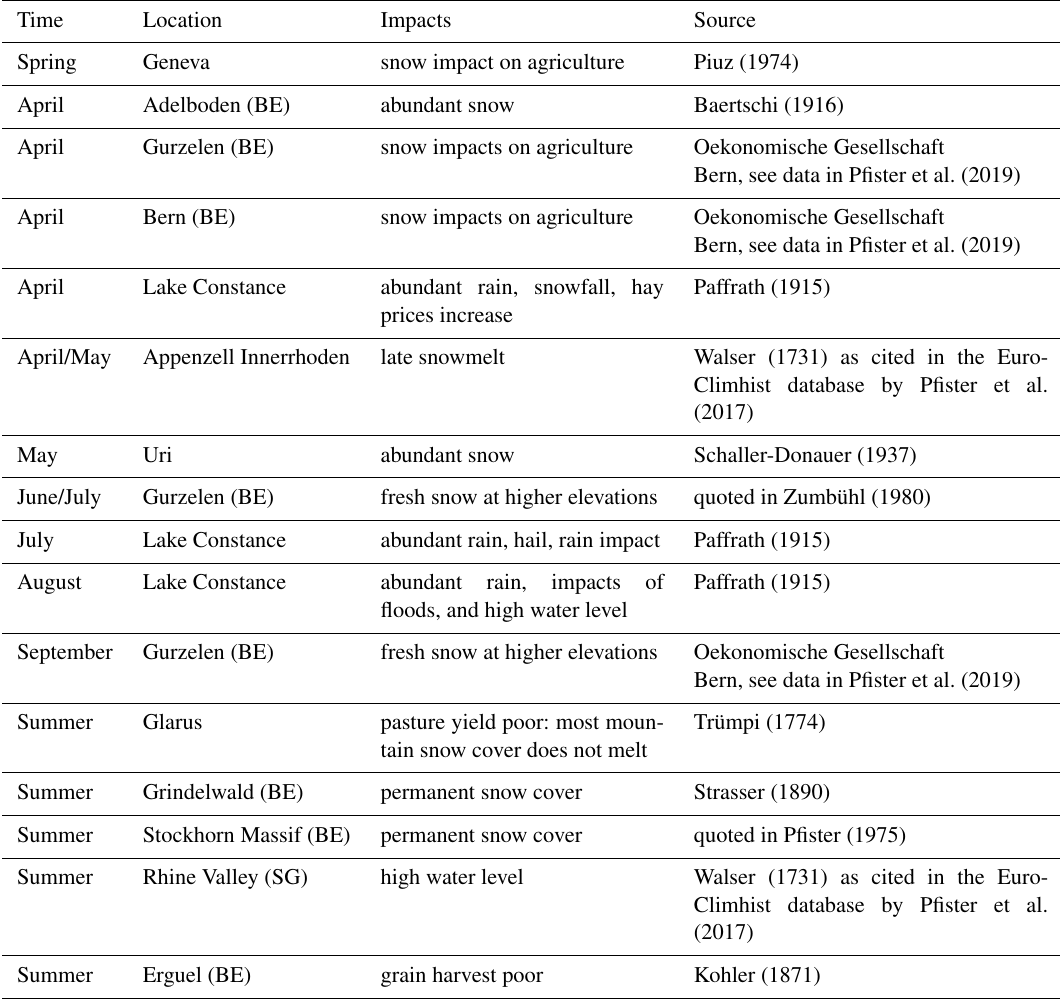
Table 3. Selection of registered weather impacts from the wet and cold weather in Switzerland in the summer half year of 1770 based on